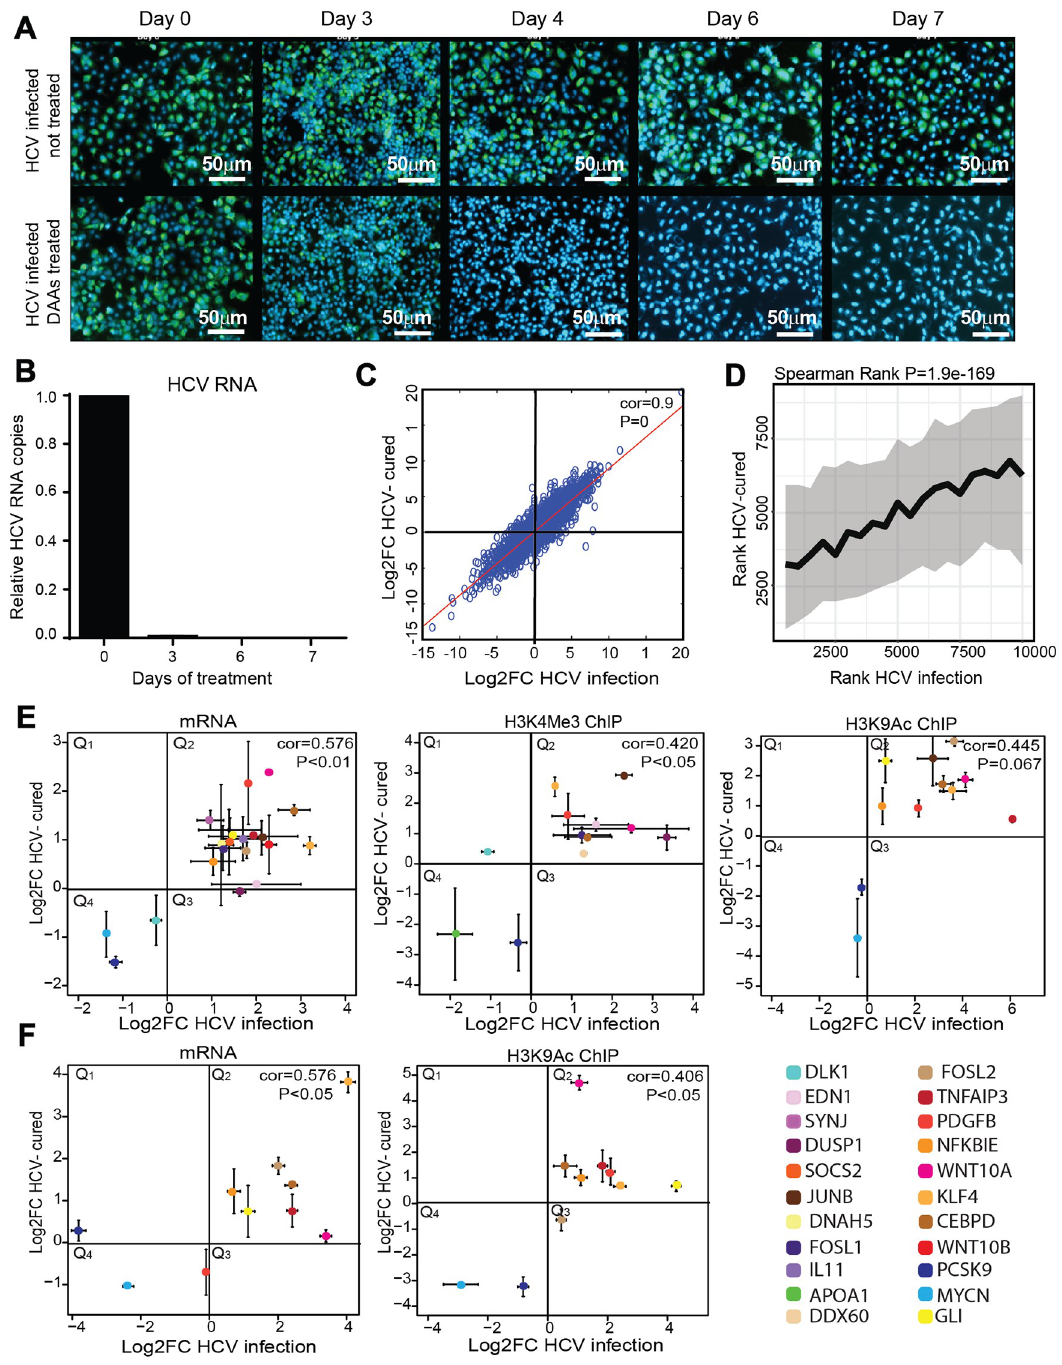
Fig 2. Epigenetic signature following cure of HCV by DAAs. (A) Immunostaining to evaluate therapeutic potential of DAAs in HCV-infected cells. HCV-infected Huh7.5 cells, treated or not treated with DAAs were stained with HCV-positive serum and anti- human 488 Alexa fluor as secondary antibody to follow the eradication of HCV infection following treatment. Infection was visualized by fluorescence microscopy. Scale bars: 50 μ m. (B) The therapeutic potential of DAAs in HCV infected cells was evaluated by qRT-PCR. Levels of HCV RNA in the cells were quantified by qRT-PCR using primers for the HCV RNA 3’ UTR. Relative HCV RNA copies are calculated for Huh7.5 cured cells compared to non-infected Huh7.5 cells (also treated with DAAs) per ng of total cellular RNA. Differential expression was calculated using the equation of 2 (- ΔΔ Ct) , with the GAPDH as an endogenous control. Means mRNA levels of HCV are shown ± SD from three independent experiments. (C) Scatter plot of RNA level in HCV-cured cells (fold change was calculated compared to control cells) compared to HCV-infected cells (fold change was calculated compared to non-infected cells) and evaluated by qRT-PCR (Spearman Rank cor = 0.91, p = 0). Four biological replicates were performed. (D)